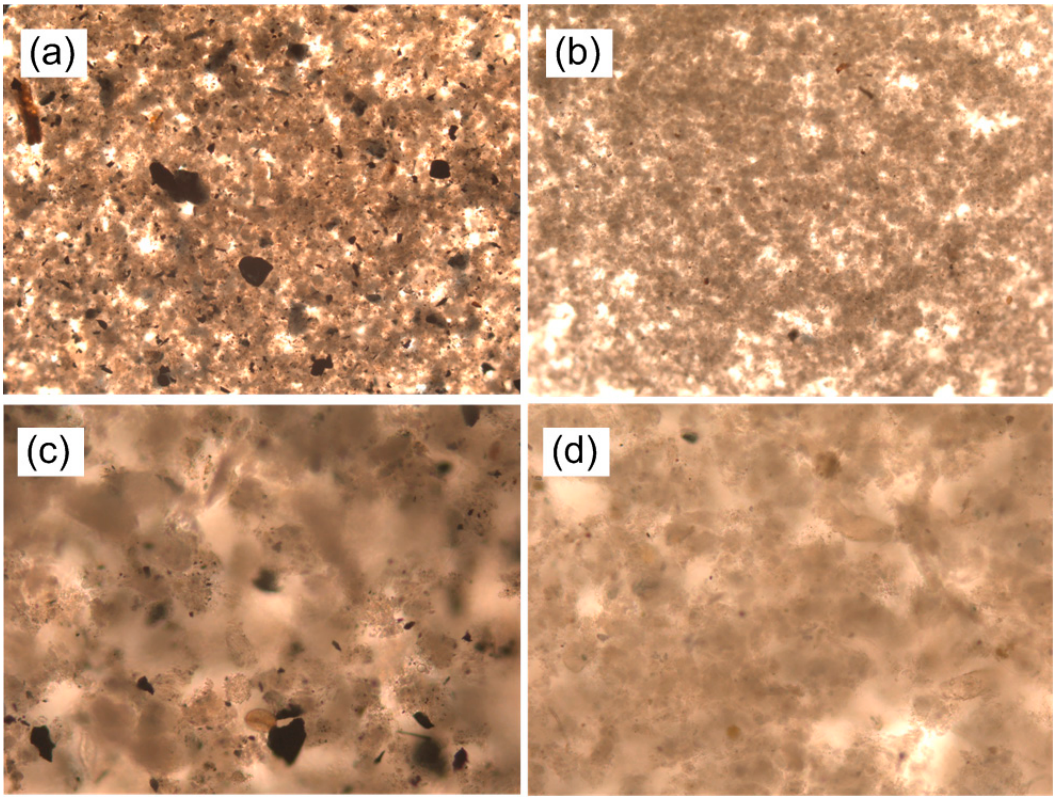
Figure 4. Microscopic examination of two systems: ( a ) 5 × , ( c ) 10 × of PAC-DMBR; ( b ) 5 × , ( d ) 10 × of C- DMBR.